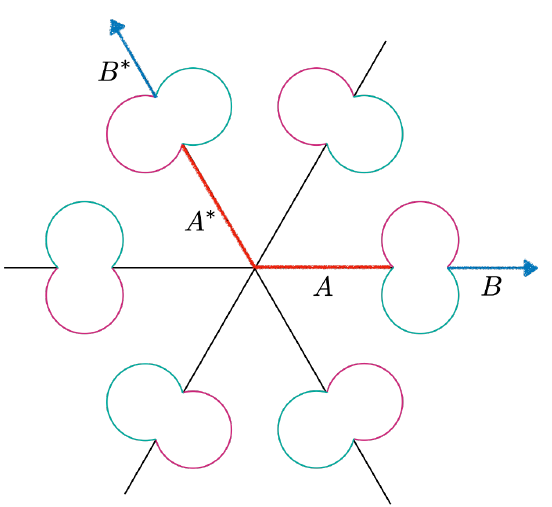
Figure 10 . The Schottky domain for n = 6 and m = 1 . Note the shift of the dual regions A ∗ and B ∗